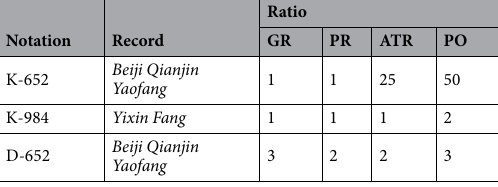
Table 1. Historical record of KXS series